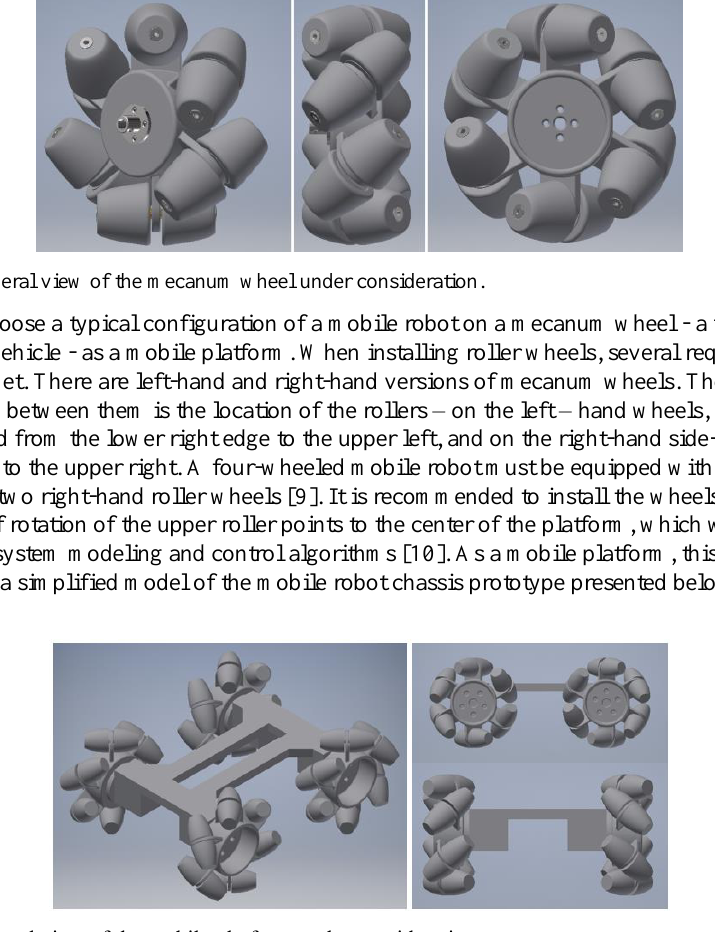
Fig. 4. General view of the mobile platform under